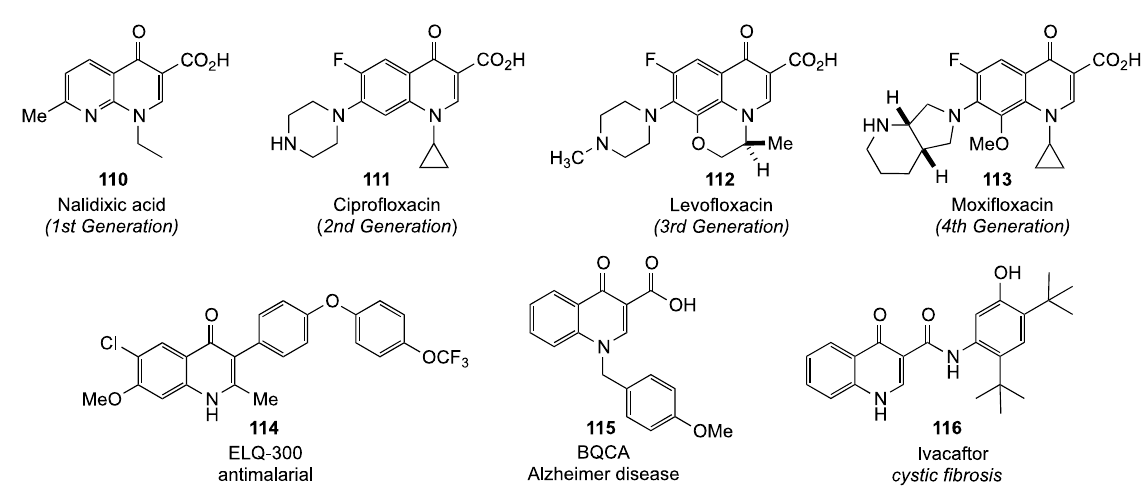
Figure 5. Drug compounds incorporating 4( 1H